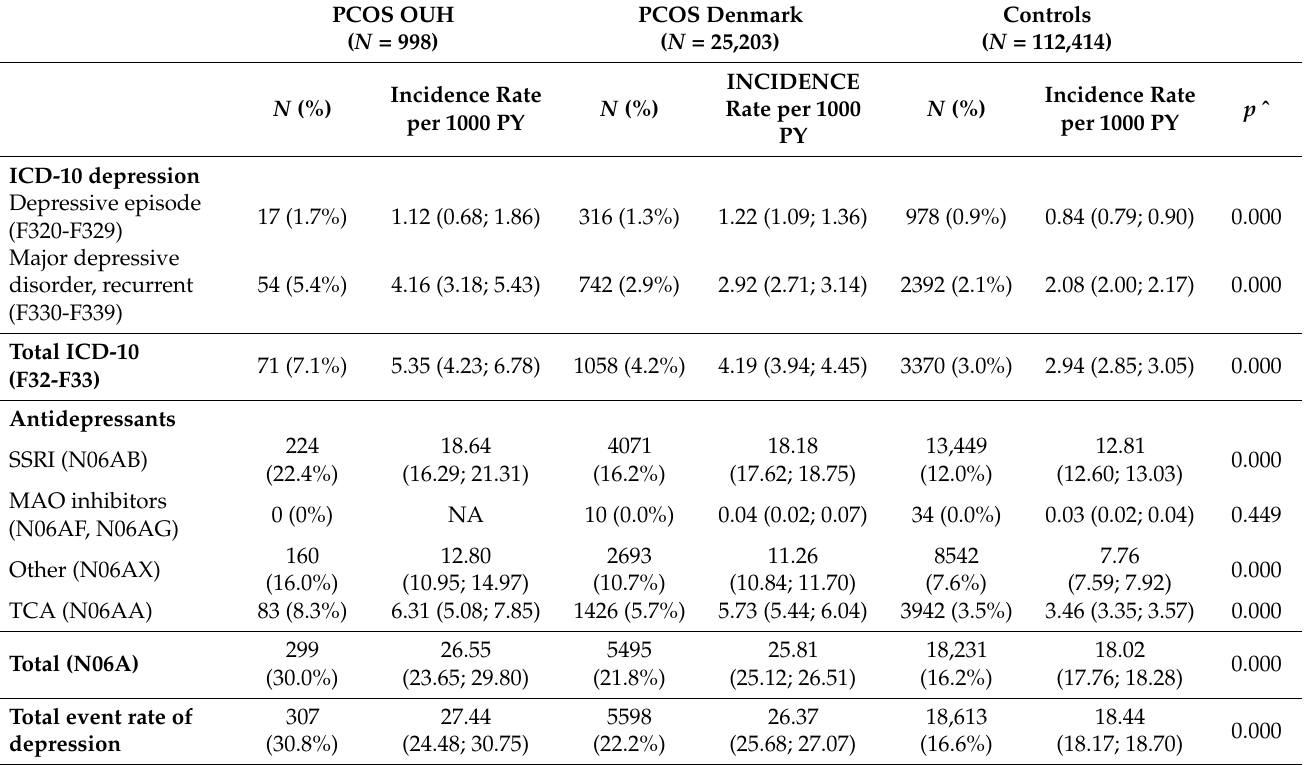
^ Chi square test between PCOS Denmark and controls.